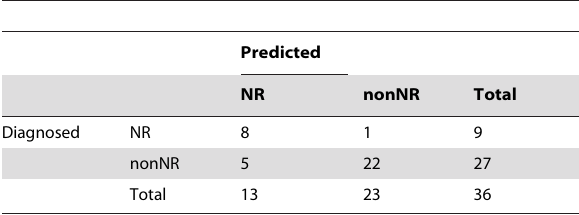
Table 8. Quality of NR-prediction by DLDA with IFN related gene